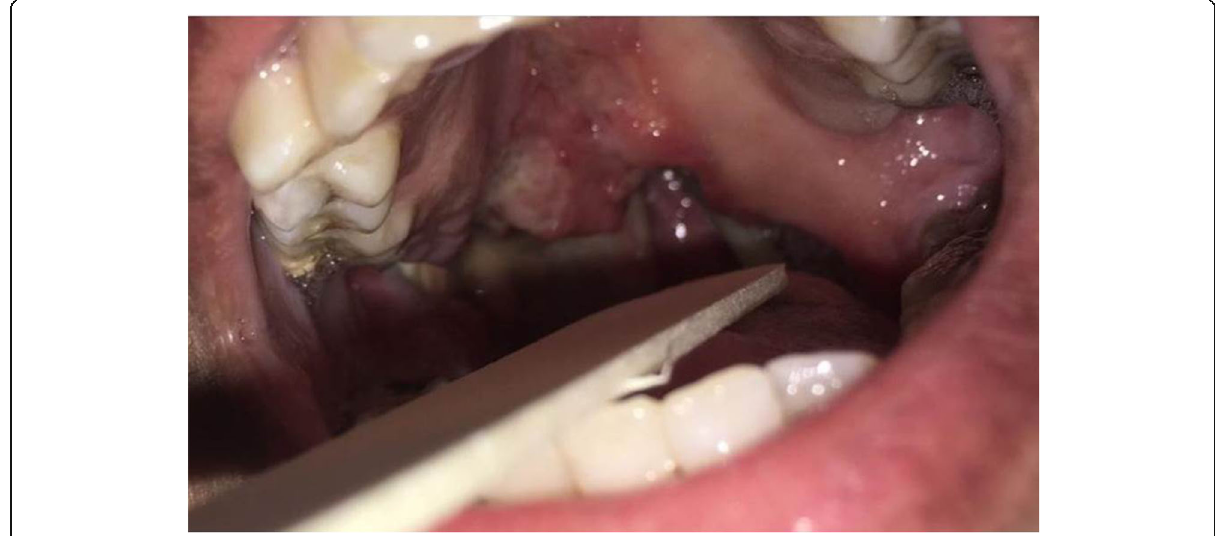
Fig. 1 Oropharynx of the patient: the lesion eroded the right tonsil and the right side of the soft palate and the uvula. Patient had